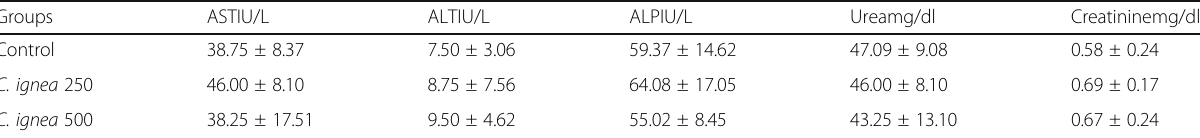
Table 2 Effect of C. ignea aerial parts extract on the liver and kidney function tests Groups